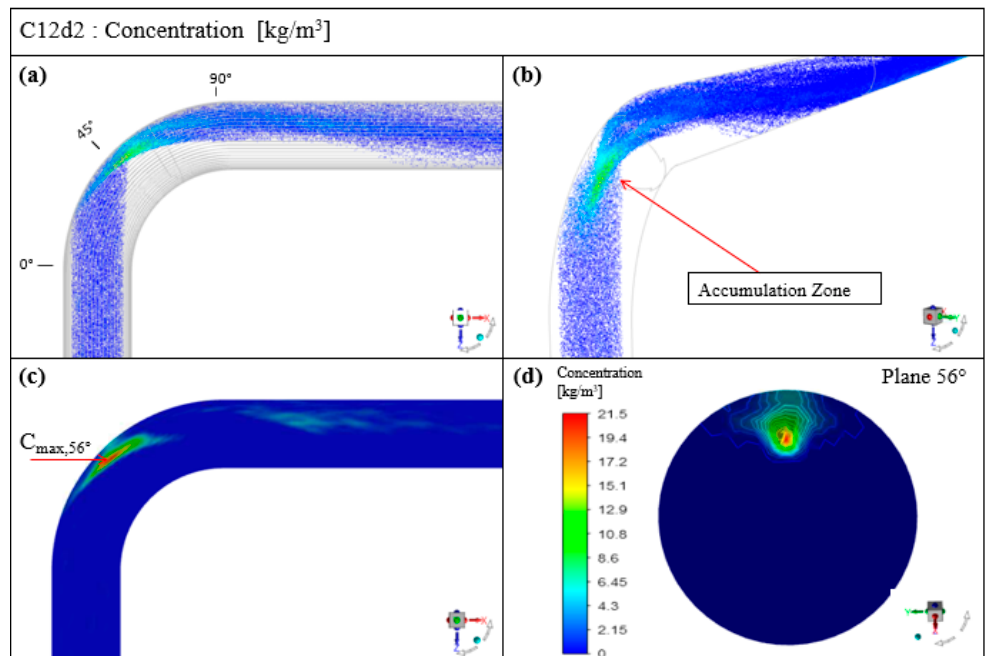
Figure A8. Results of particle concentration. Case C12d2. ( a ) Instant positioning of the X-Z plane particles ( b ) Instant positioning of the particles in 3D view ( c ) Concentration contour in the X-Z plane of the mid-section of the pipe ( d ) Concentration contour in the Z-Y plane of the maximum concentration cross section. Snapshots are taken for a statistically steady flow.